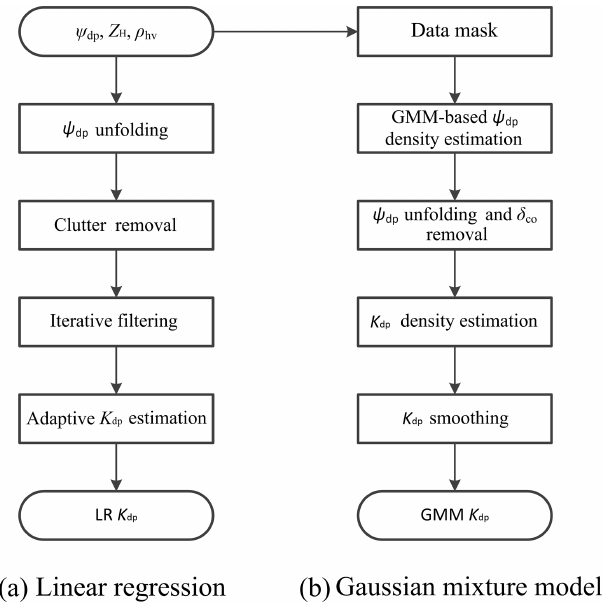
Figure 1. Flowcharts of K dp estimation algorithms used in the MZZU radar: (a) linear regression model and (b) Gaussian mixture